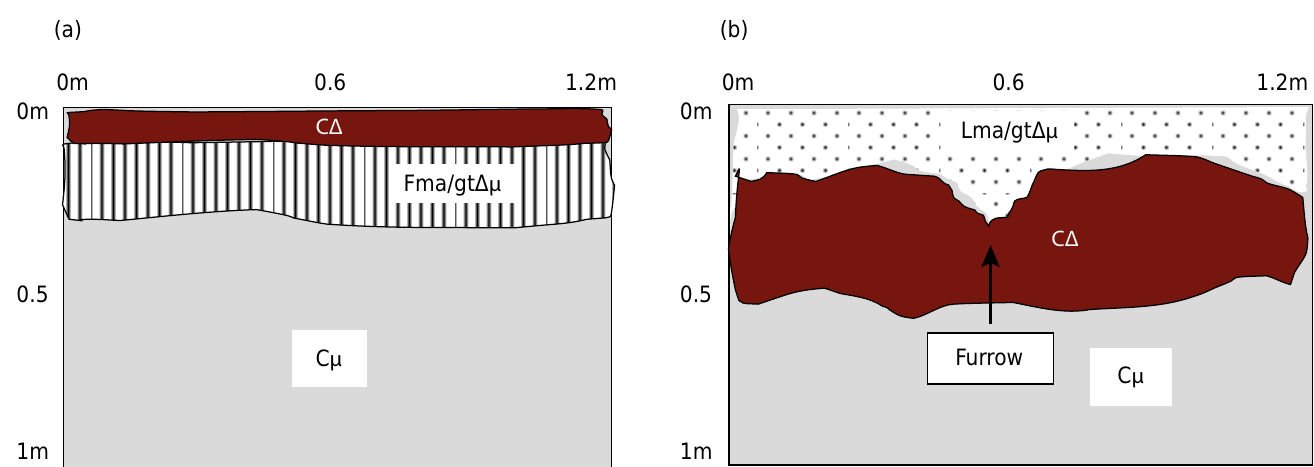
Figure 2. Design, means of three pits for each management practice (a) - perennial pasture and (b) - sugarcane of the stratification of clod organization in the soil profile. Stratification of clod organization: C (Continuous), F (Cracked), and L (Loose), and morphologically homogeneous internal state of the clods: Δ (No structural porosity visible), Δμ (Some structural porosity visible), and μ (High structural porosity). ma and gt: means medium (0.06-0.10 m) and large (>0.10 m) diameter size of clods,